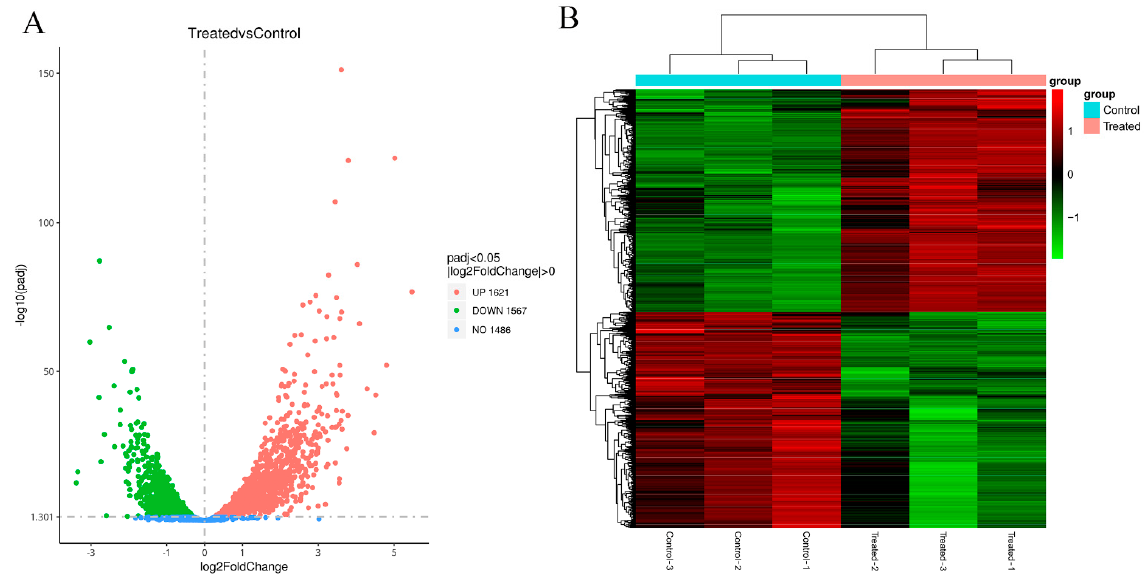
Figure 2. Differentially expressed gene analysis. ( A ) Volcano plot for all DEGs. ( B ) Cluster heatmap of DEGs. The columns represent samples, and the rows represent genes.